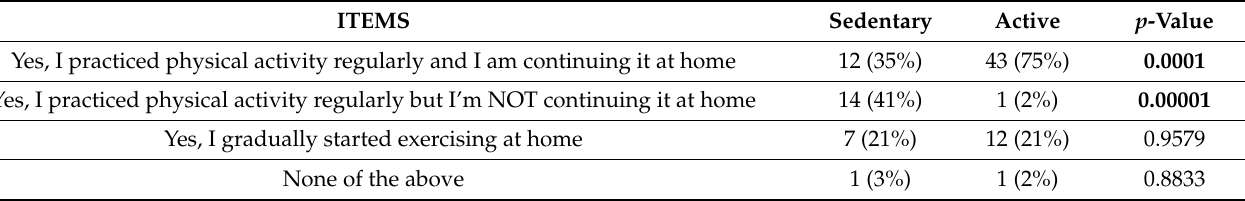
Table 5. Reported changes (%) in physical activity behavior during the lockdown by sedentary and active adolescents. ITEMS Sedentary Active p -Value